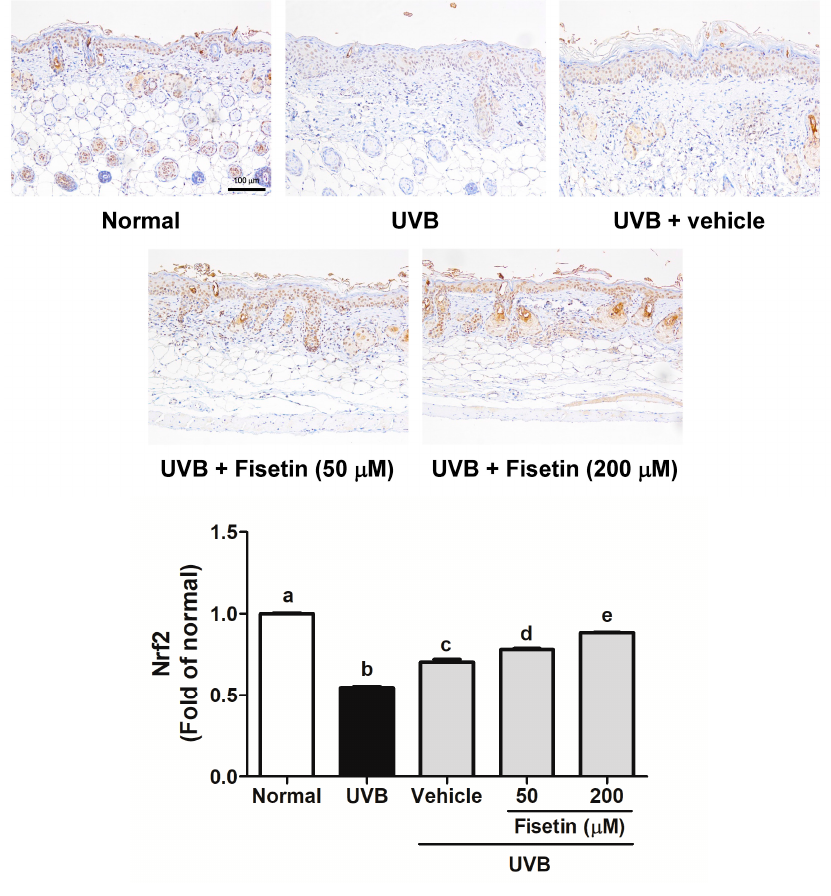
Figure 12. Immunohistochemical staining of Nrf2 expression in the epidermis of the mouse skin slices. Fisetin increases Nrf2 overexpression (200×). a–e: Values not followed by a common letter are significantly different ( p <